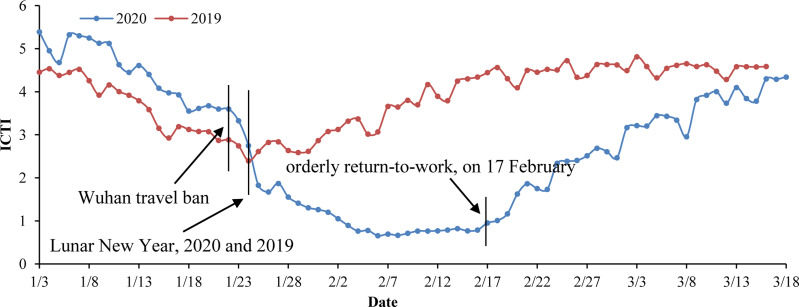
Intracity travel intensity in Wenzhou.*ICTI travel intensity refers to the ratio between the number of urban travellers and the resident population of the city (from the Baidu Migration Big Data Platform, https://qianxi.baidu.com).